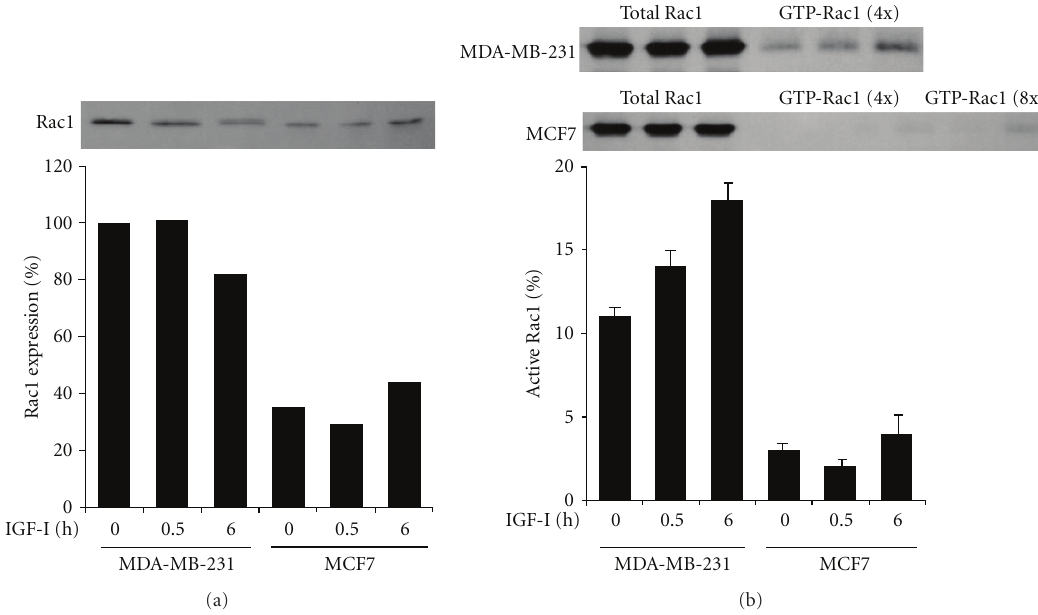
Figure 3: Overexpression and activation of Rac1 by IGF-I in MDA-MB-231 but not in MCF7 cells. (a) Cells after stimulation with IGF-I for 0, 0.5, or 6h were lysed and processed for immunoblotting with anti-Rac1 antibody. Band intensity was measured and values are given as Rac1 expression relative to that in unstimulated control MDA-MB-231 cells. (b) After stimulation with IGF-I, total and activated Rac1 were immunoprecipitated from the cell lysates and 4- or 8-fold concentrated cell lysates, respectively, and processed for immunoblotting with anti-Rac1 antibody. Band intensity was measured and the mean (SD) values of triplicate experiments are given as the amount of active Rac1 relative to total